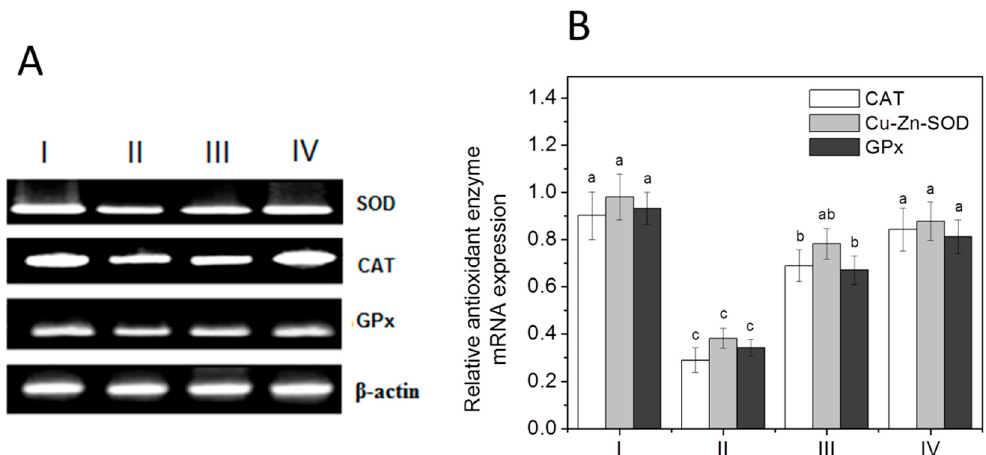
Figure 2. E ff ect of EEAB on mRNA expression of antioxidant enzymes in the liver of CCl 4 -treated rats. ( A ) RT-PCR profile. ( B ) Histogram of relative transcript levels. Treatments—I: control. II: CCl 4 30%. III: EEAB (250 mg / kg) + CCl 4 30%. IV: EEAB (500 mg / kg) + CCl 4 30%. Values are mean ± SEM ( n = 3). Means with di ff erent su ffi x letters (a, b and c) di ff er significantly ( p < 0.05).